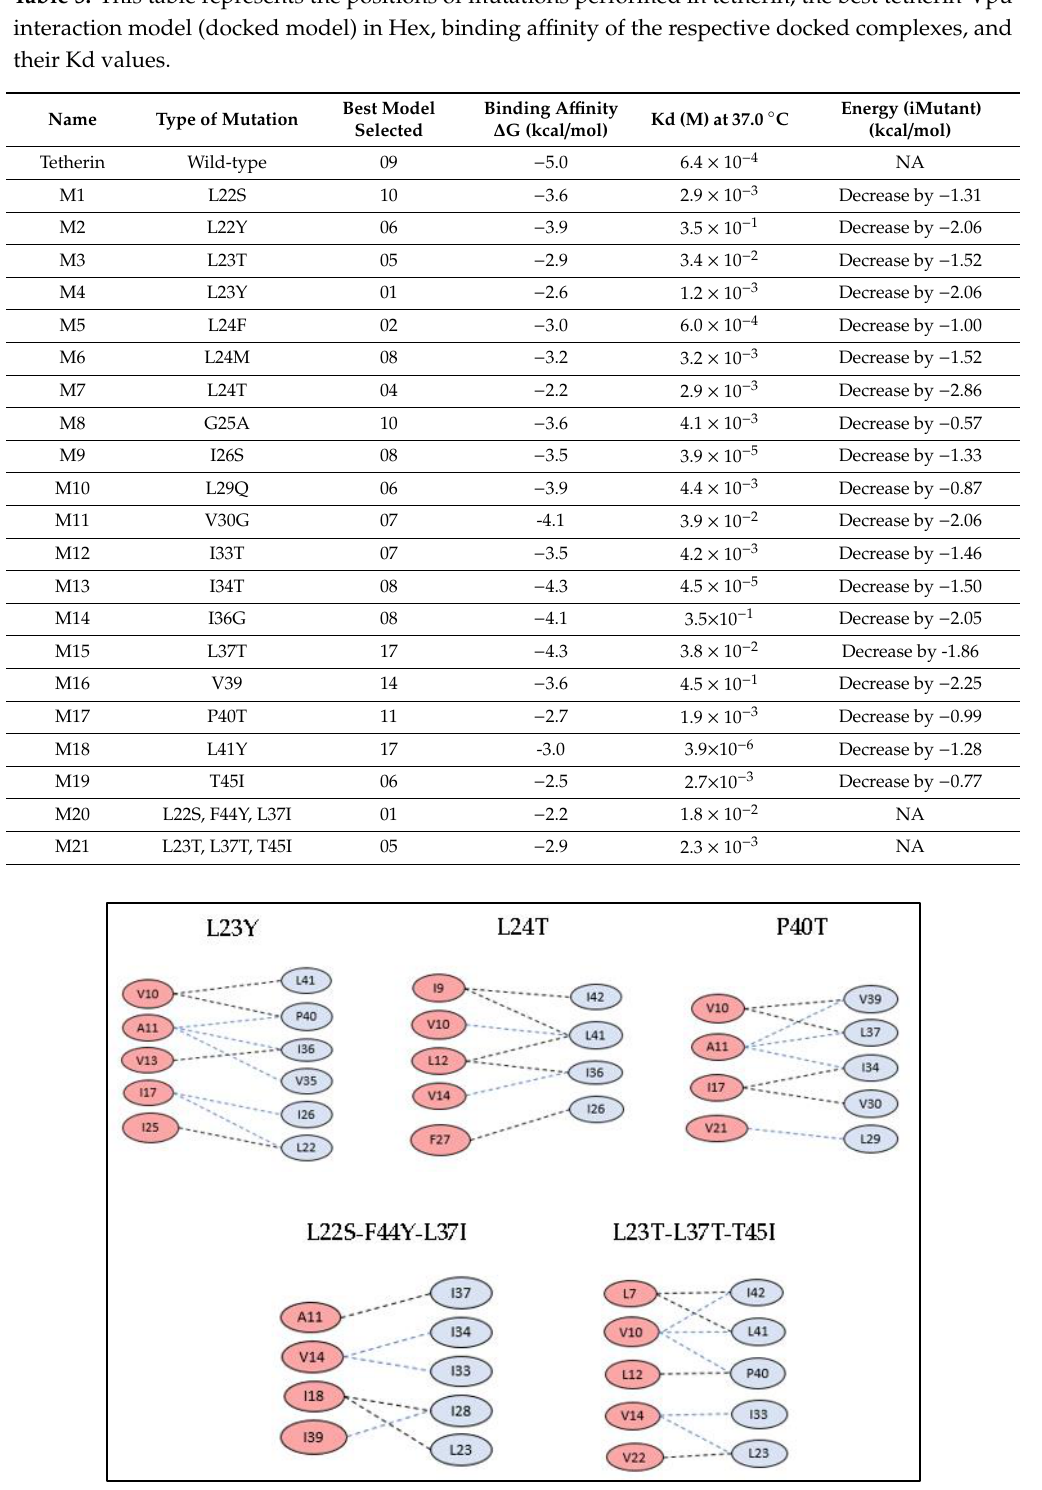
Figure 6. The hydrophobic interactions within 5 Å for tetherin mutants having reduced binding affinities and minimal hydrophobic connections.